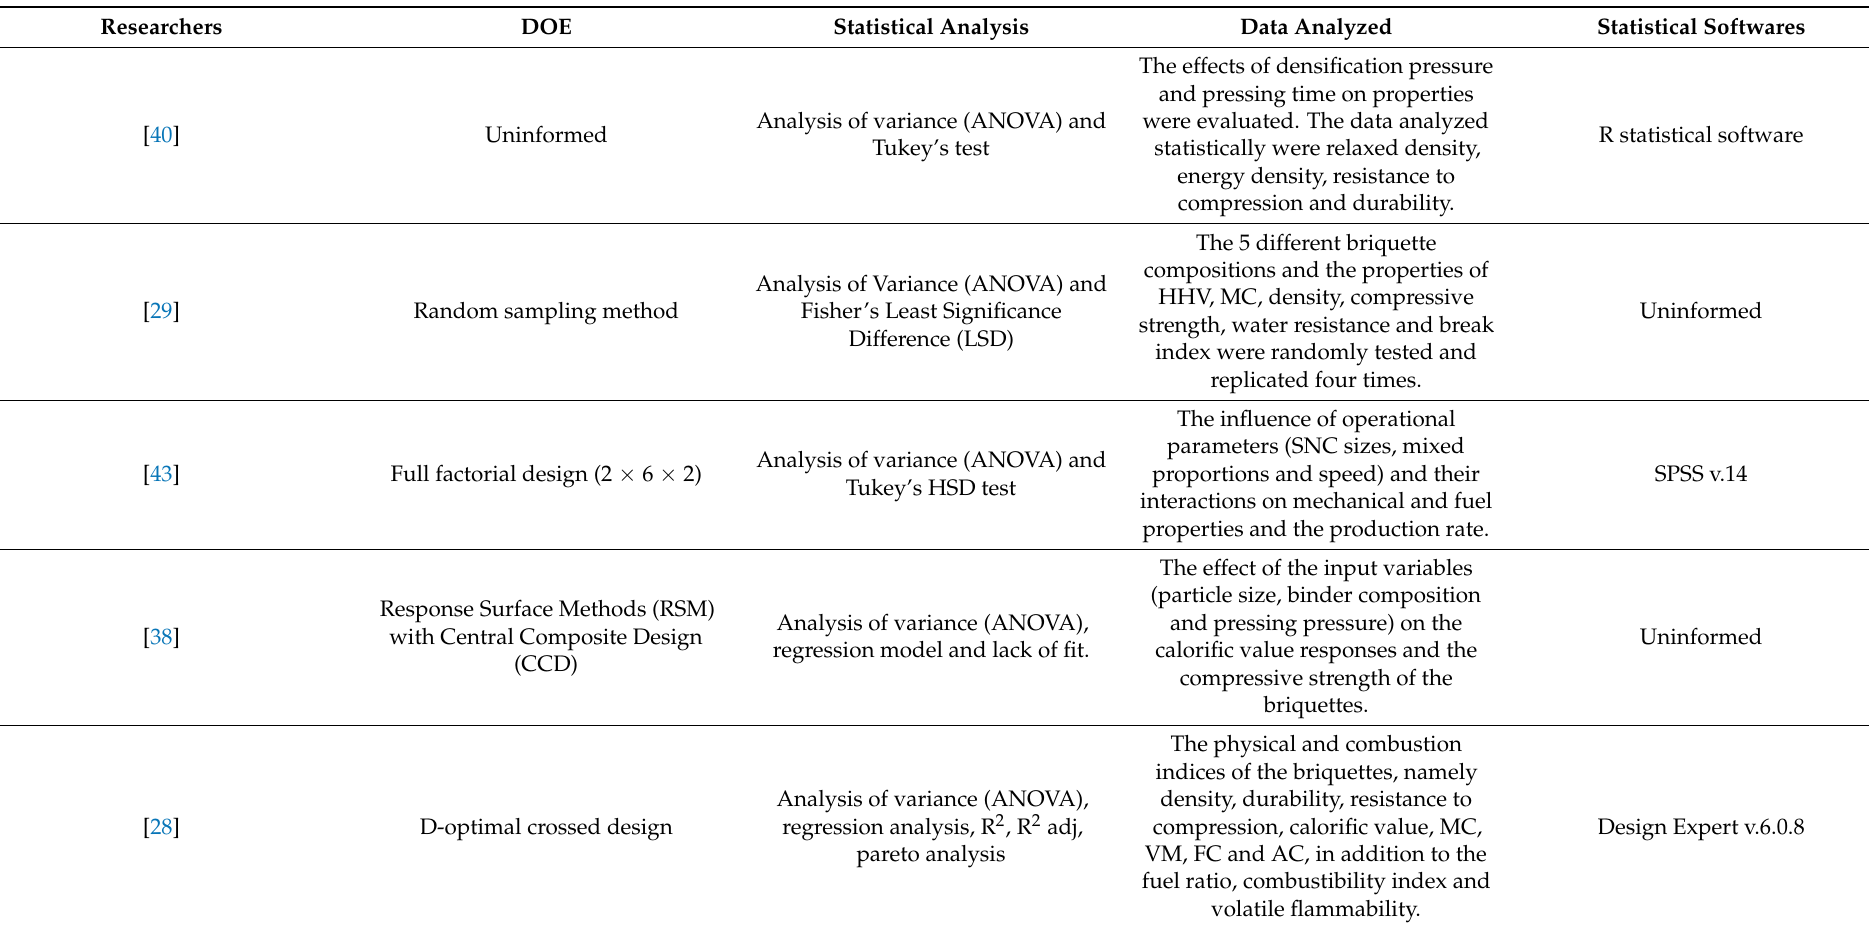
Table 12. Studies conducted following a DOE, mathematical models and statistical analyzes to assess process